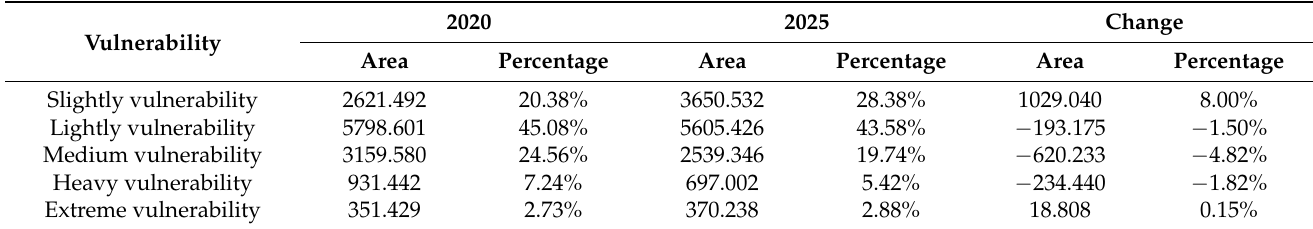
Figure 9. From the ecological vulnerability results in 2025, it can be seen that the ecological vulnerability of Shenyang in 2025 is light vulnerability and medium vulnerability are dominant, and in terms of quantity, the percentages of area of slight vulnerability, light vulnerability, medium vulnerability, heavy vulnerability and extreme vulnerability are 28.38%, 43.58%, 19.74%, 5.42% and 2.88%, respectively. The results were imported into ArcGIS software to compare the 2025 ecological vulner- ability simulation results with the 2020 status quo data, and the area change and transfer results were obtained as shown in Figure 9 and Table 7: By comparing the 2025 ecological vulnerability simulation results with the 2020 status quo data in Shenyang, it can be seen that in the simulation results in 2025, the area of the slight and extreme vulnerability areas increased, among which the slight vulnerability area In the simulation results of 2025, we can see that the area of slight vulnerability area and extreme vulnerability area will increase, among which slight vulnerability area will increase by 1029.040 km 2 , or 8.00%, and extreme vulnerability area will increase by 18.808 km 2 , or 0.15%. Meanwhile, the area of light, medium and heavy vulnerability area will decrease slightly, among which light vulnerability area will decrease by 193.175 km 2 , or 1.50%, medium vulnerability area will decrease by 620.233 km 2 , or 4.82%, and heavy vulnerability area will decrease by 234.440 km 2 , or 4.82%. Decrease 234.440 km 2 , accounting for 1.82% decrease Table 7. Changes of ecological vulnerability in Shenyang in 2020 and 2025 (km 2